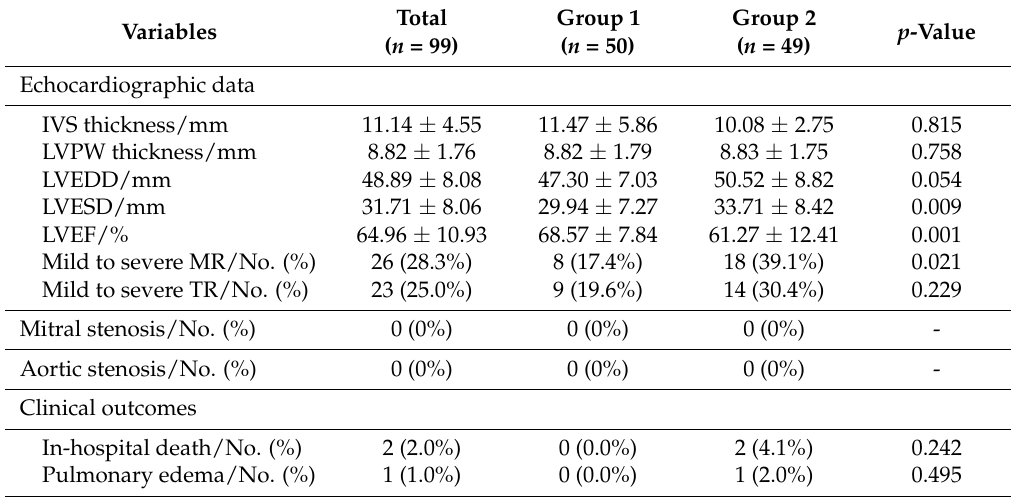
Total Group 1 Group 2 p -Value ( n = 99) ( n = 50)